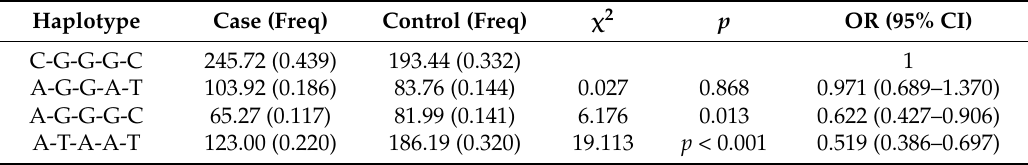
Table 7. The discrepancy of haplotype frequencies of five CETP SNPs between the control and case group in the